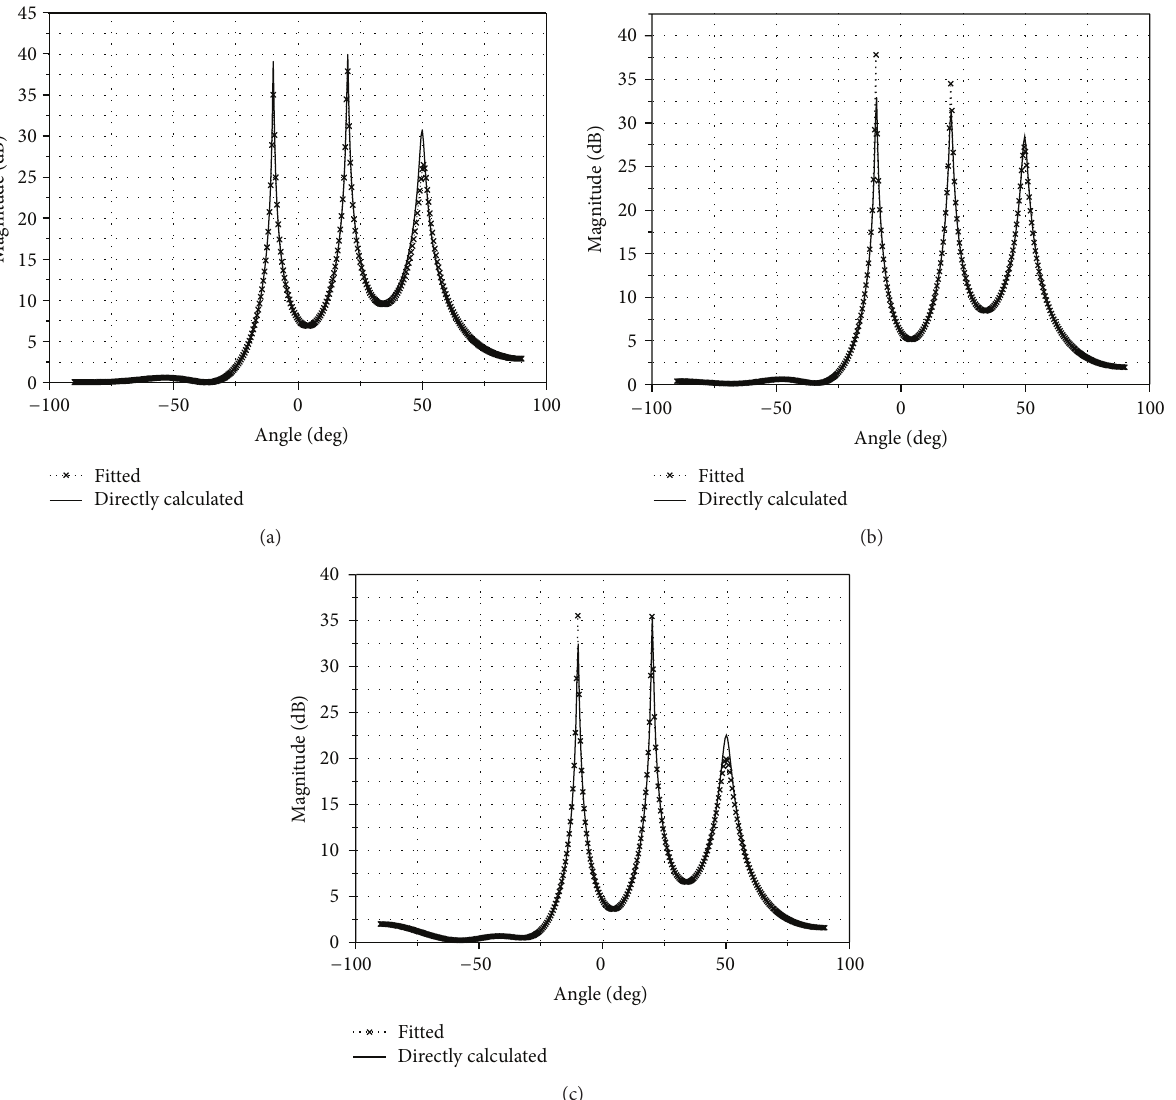
Figure 7: Comparison of DOA estimations due to the directly calculated compensation matrices via element pattern reconstruction method and the fitted compensation matrices via complex-curve fitting at (a) 2.5 GHz, (b) 2.65 GHz, and (c) 2.8